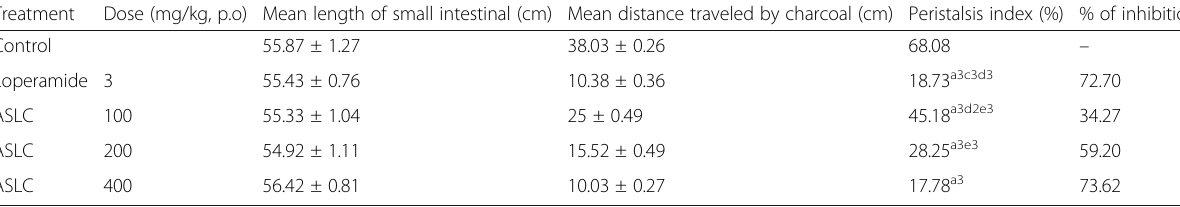
Table 3 Effect of the aqueous stem extract of L. camara on normal gastrointestinal transit in mice